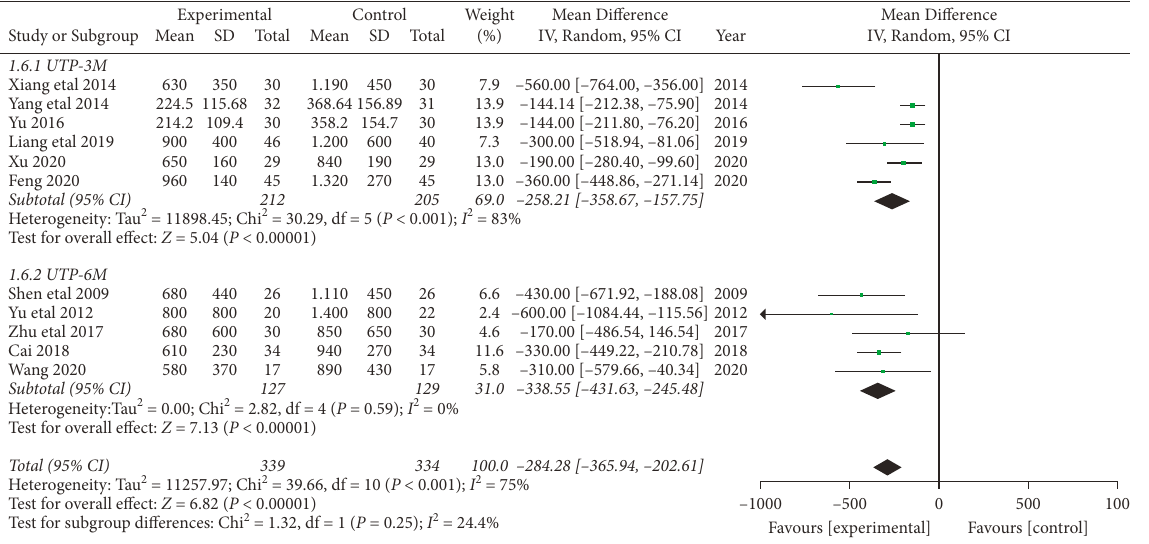
Figure 6: GTW combined with RASI versus control UTP-3 months versus 6 months.